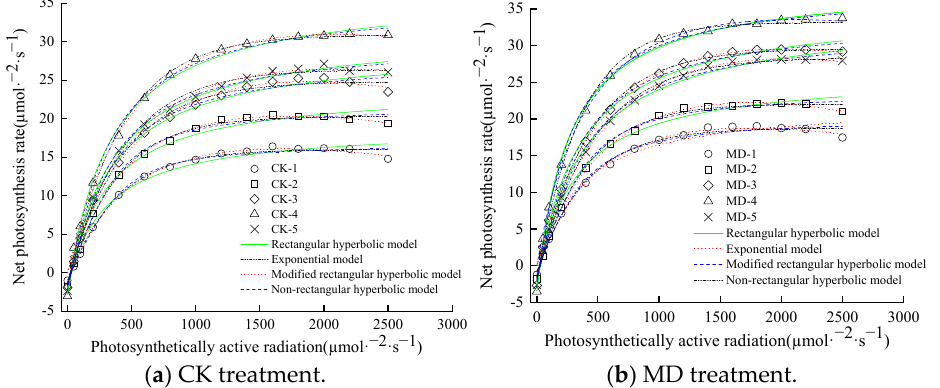
Figure 6. Comparison of the fitting effects of four models of two irrigation water on spinach light